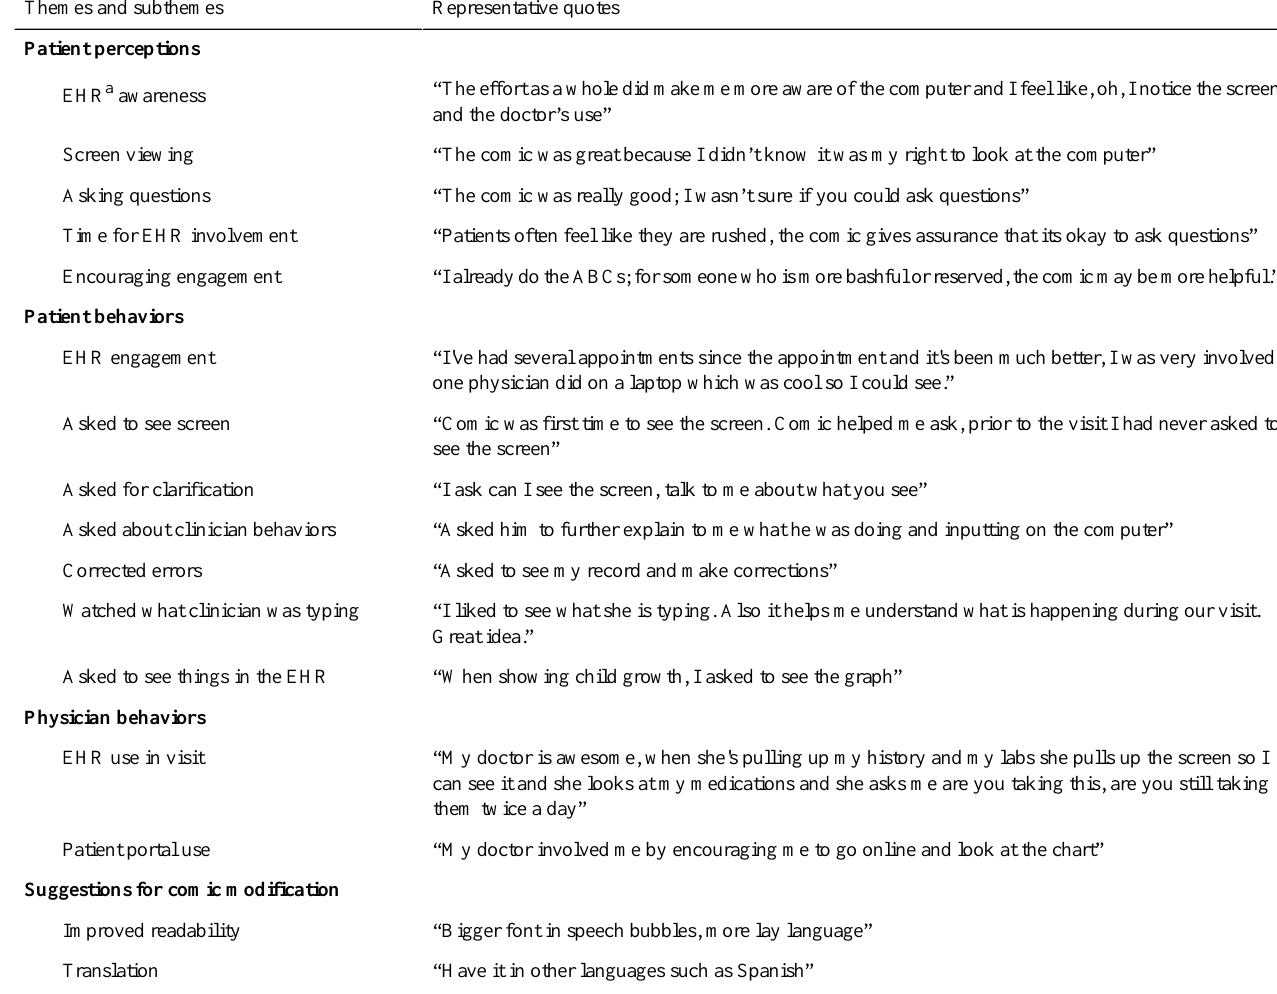
Representative quotesThemes and subthemes